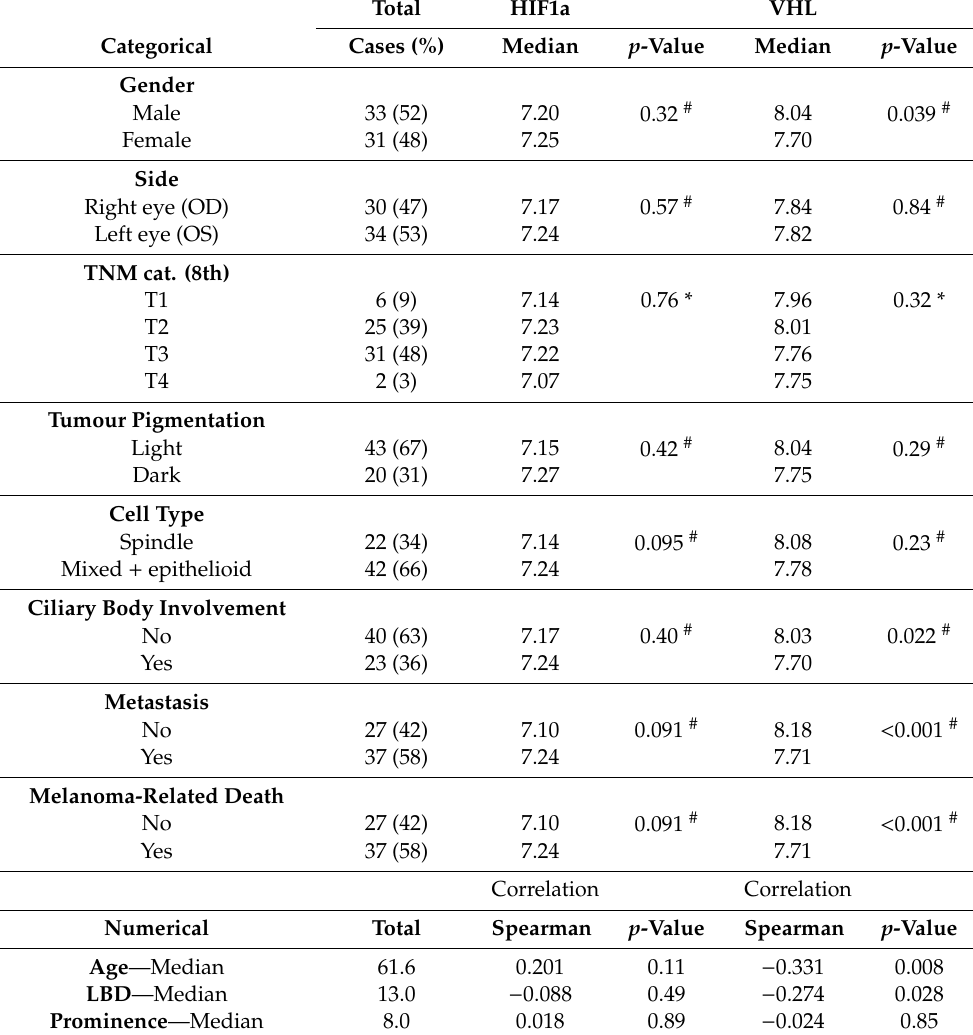
Table 1. Clinical characteristics of the study group (Leiden data, n = 64), and messenger RNA (mRNA)